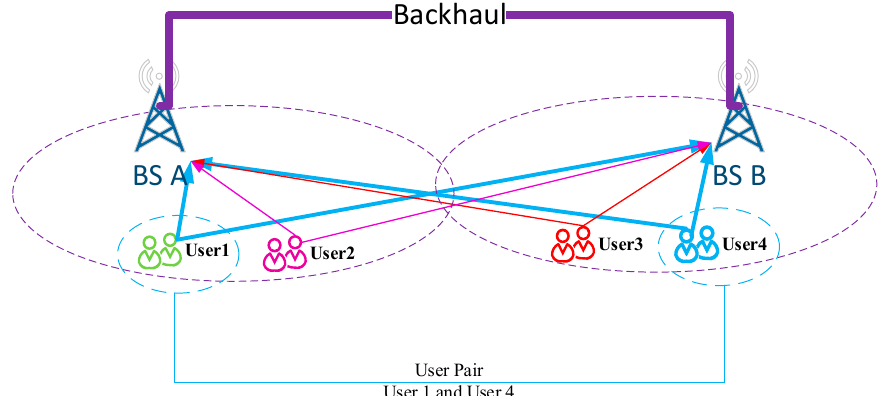
Figure 1. Cooperative Scenario with capacity constraint backhaul system. Users located at different base stations will transmit uplink information and base stations will receive information from every users.